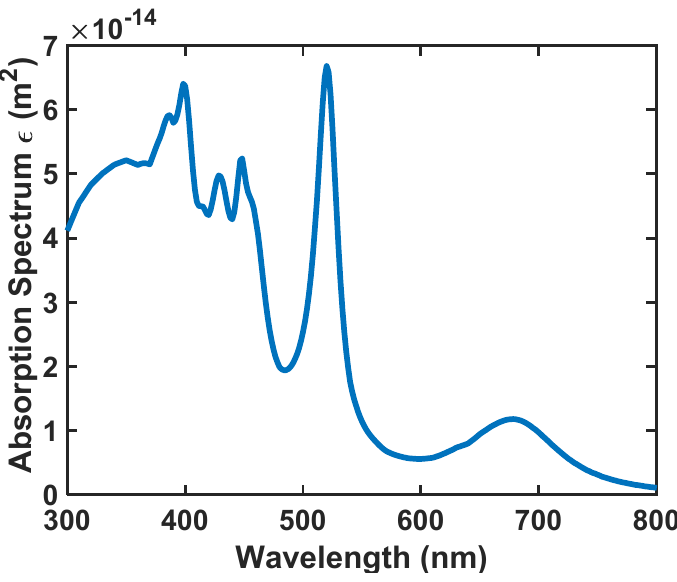
Figure 8. The absorption spectrum of the nanoparticle’s SiO 2 /Si with R = 85 nm.